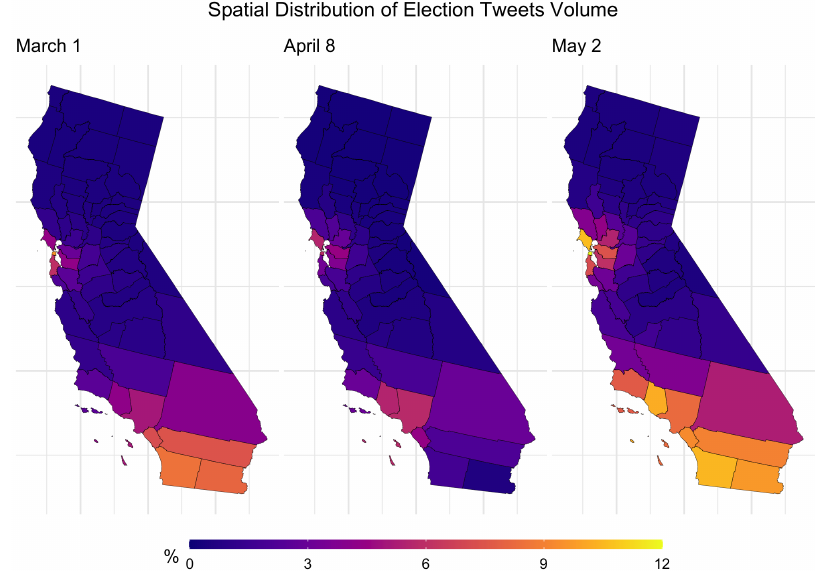
Figure 6. County-level maps for California. It shows the spatial distribution of proportional tweet volumes for the three time points on the COVID NEWS (presidential election)